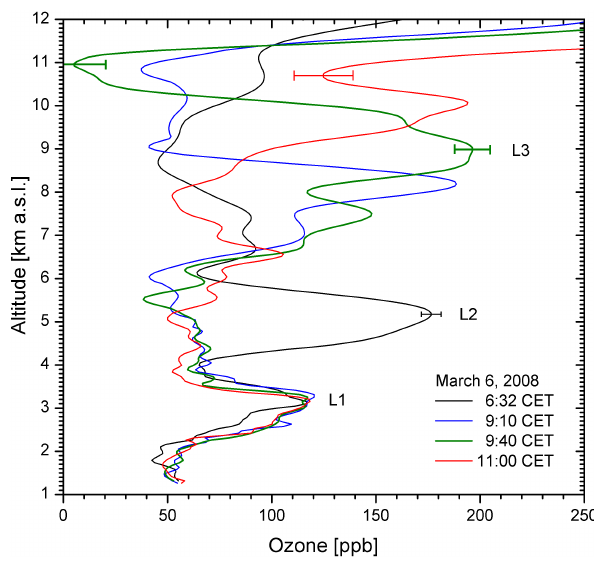
Figure 3. Selected ozone profiles from the measurement series shown in the upper panel of Fig. 1; a few error bars representative for the respective altitude ranges are given for a judgement of the data quality that is influenced by the strong light absorption in the intrusion layers. The Munich thermal tropopause was located at 11.3 km at 1:00 CET (0:00 UTC) and at 10.6 km at 13:00 CET.